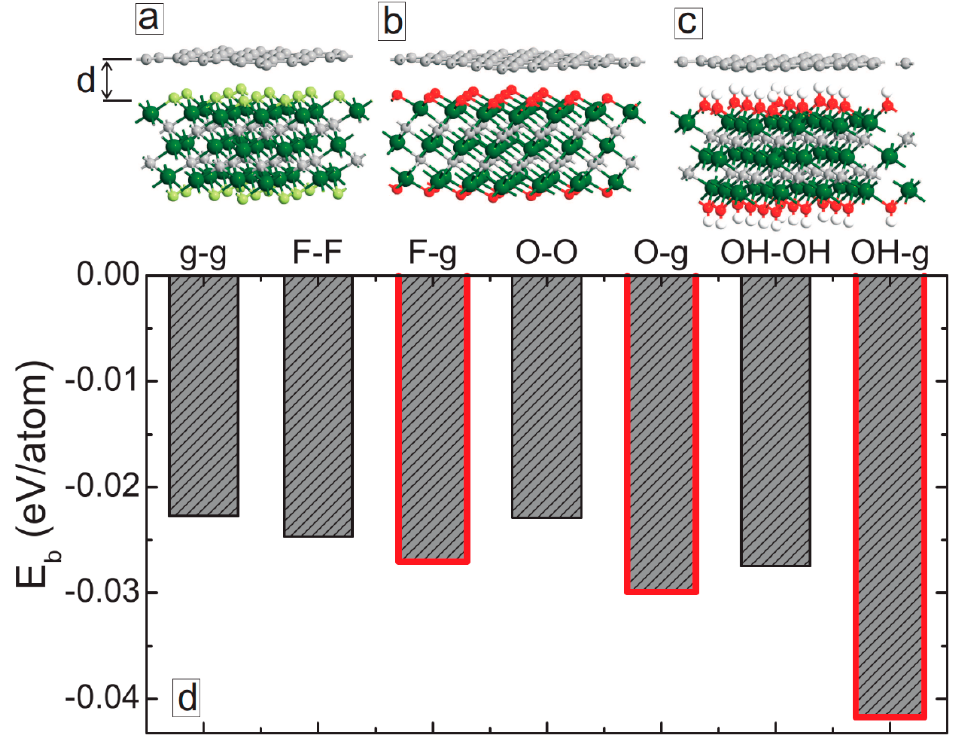
Figure 2. ( a – c ) Fully optimized structures of MXene/graphene systems. ( d ) Binding energies (per atom) of graphene/graphene, MXene/MXene, and MXene/graphene bilayer systems. The results for MXene/graphene systems are highlighted by thick red curves.